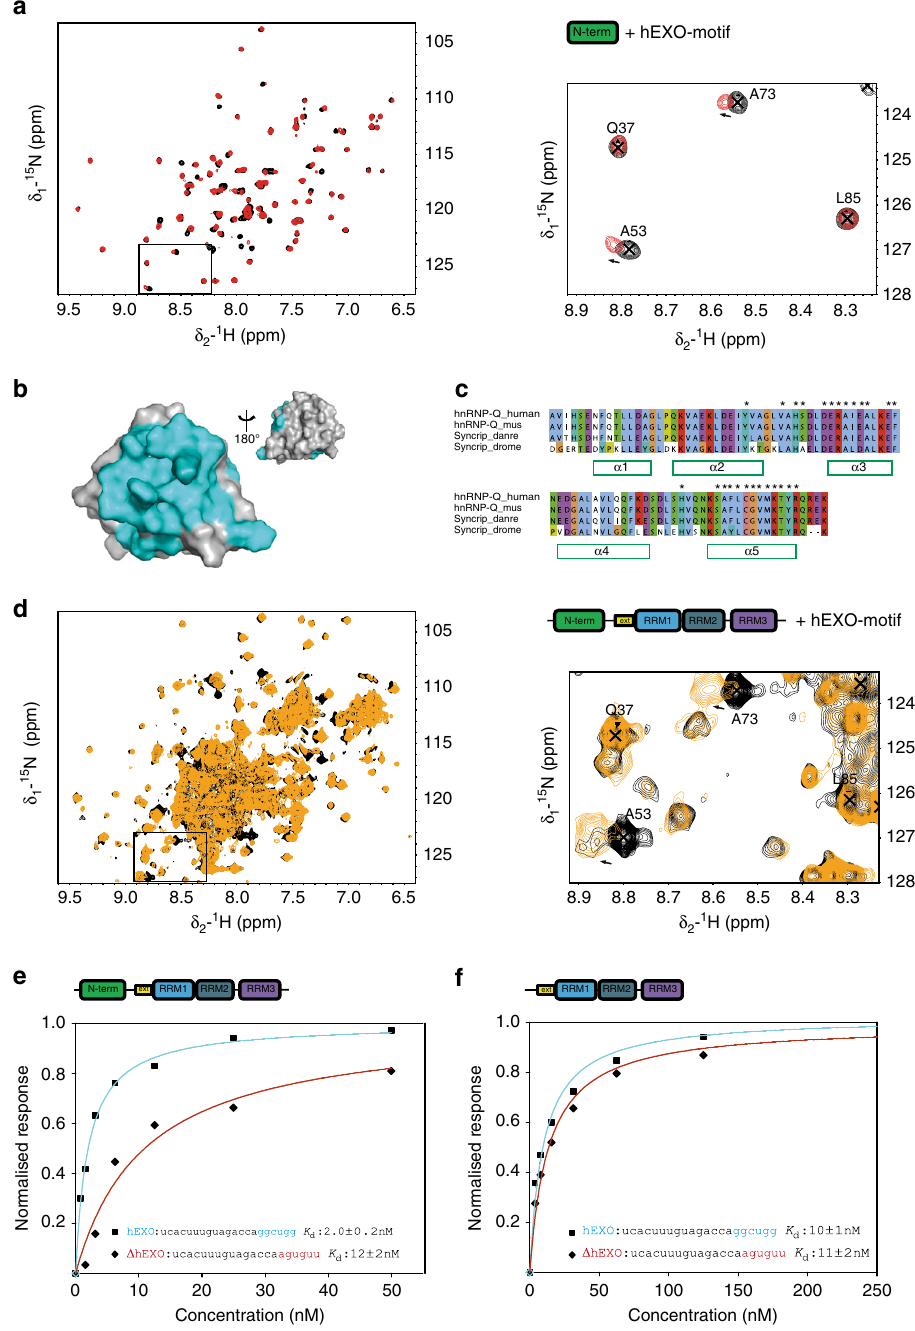
Fig. 7 The NURR domain mediates the speci fi c recognition of miR-3470 hEXO-motif. a Binding of the NURR domain to the AGGCU hEXO-motif monitored by NMR. Left: superimposition of the free (black) and RNA-bound (1:1 ratio, red) protein spectra. Right: zoom of the boxed region. Residues names are annotated. b Residues whose amide resonances are affected by the binding of the hEXO RNA are mapped in blue on the surface of the NURR domain. c Residues with signi fi cantly perturbed resonances upon hEXO binding are indicated with an asterisk above the sequences of the human and Drosophila proteins. d Binding of the four-domain NeR1R2R3 construct to the AGGCU hEXO-motif. Left: superimposition of the free (black) and RNA-bound (1:1 ratio, orange) protein spectra. Right: zoom of the boxed region. Residues names are annotated as in b . e Binding of the four-domain (NeR1R2R3) protein to wild- type miR-3470 (hEXO) and mutant miR-3470 ( Δ hEXO) monitored by BLI. The hEXO and mutated sequences are highlighted in the inset in blue and red, respectively. BLI response values are plotted against the protein concentrations and normalised for better comparison. Dissociation constants are reported. f Binding of the three-domain construct (eR1R2R3) lacking the NURR domain to wild-type and mutant miR-3470, as in e . In the absence of the NURR domain, the protein no longer recognises the cognate